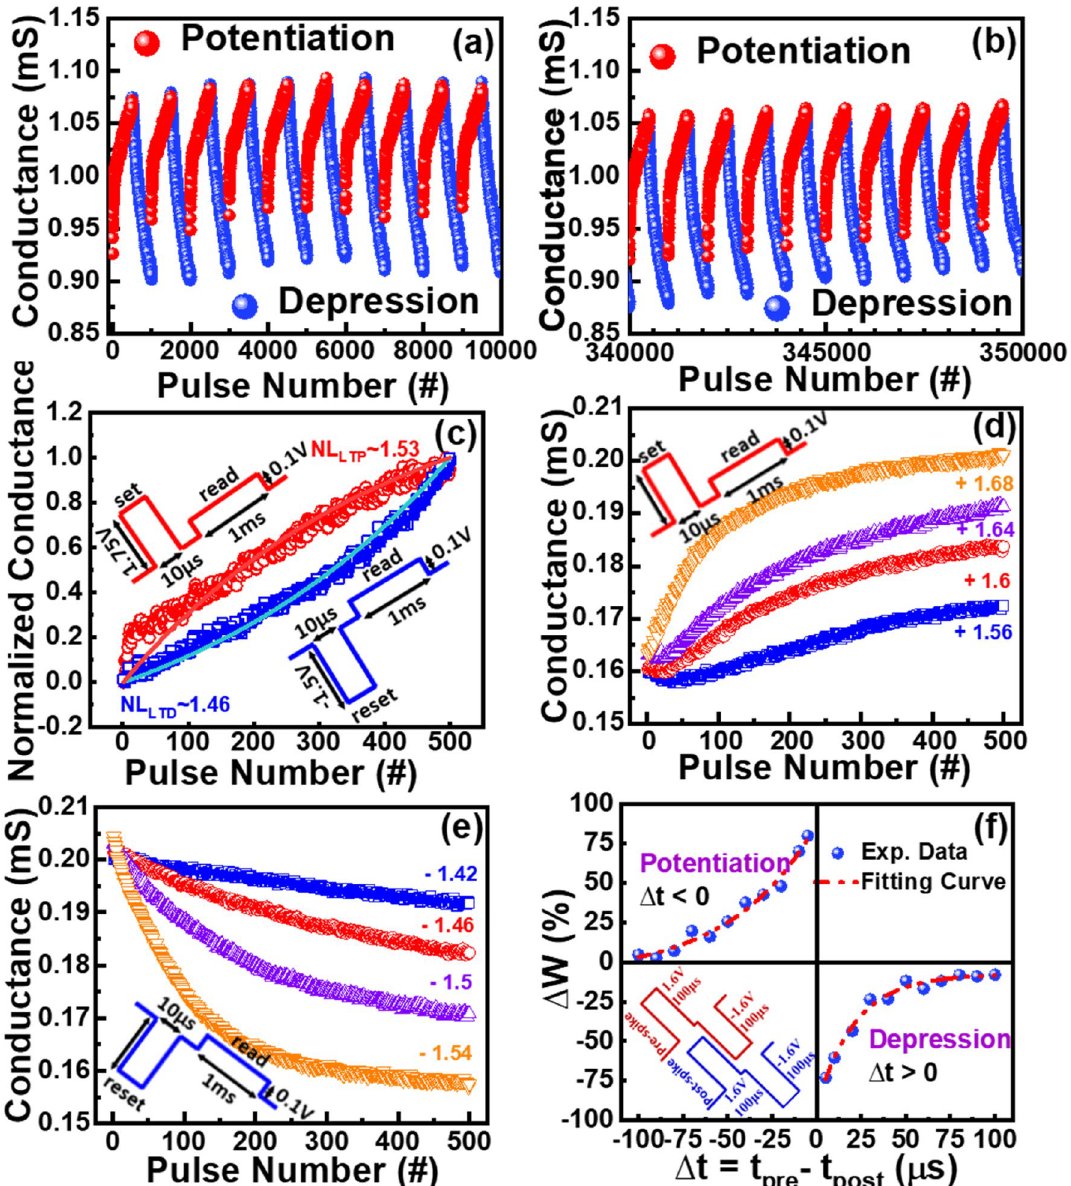
Figure 2. Pulse-induced LTP/LTD cycles of ISHI-1 device of ( a ) first and ( b ) last 20 cycles (10 epochs) with a total of 350 epochs. ( c ) Nonlinearity fitting of a typical LTP (red colour)/LTD (blue colour) cycle (inset showing the applied pulse scheme for potentiation and depression). Multi-level characteristics of the optimized ISHI-1 by controlling the pulse height for ( d ) potentiation and ( e ) depression. ( f ) Typical STDP learning behaviour of ISHI-1 synapse with the fitting curve, the pulse schemes for potentiation and depression presented in the third potentiation and depression epoch training, respectively, of the optimized ISHI-1 device. A stable 350 epochs training consisting of 500 pulses for each cycle is observed for this ISHI-1 device. Whereas, all other devices can only sustain up to 200 (ISHI-2) and 50 (ISHI-3) epochs training. To get the potentiation and depression characteristics, the optimized identical pulses of 1.6 and -1.46 V amplitude with 10 μs width for set and reset, respectively, and equal 0.1 V amplitude with 1 ms width read pulse width is applied to the ISHI-1 device, as shown in the inset of Fig. 2c. In addition to the excellent epoch training of ISHI-1 synapse, the device with the thinner (6 nm) HfOx film reduces the non-linearity (NL) values to 1.53 and 1.46 for potentiation and depression, respectively, as indicated in Fig. 2c. To find the nonlinearity values the potentiation and depression curves are simulated using Matlab codes based on the equations 17,18